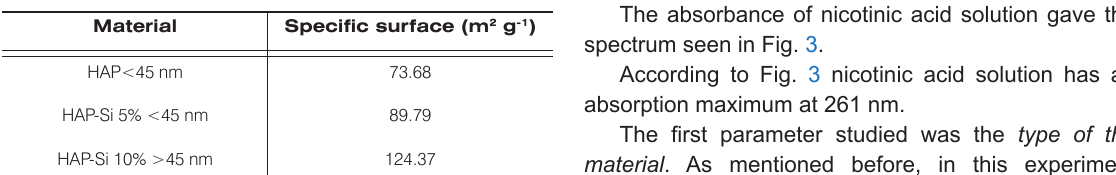
Figure 1. IR spectra of HAP (solid line), HAP-Si 5wt% Si (dotted line) and HAP-Si 10wt% Si (dashed